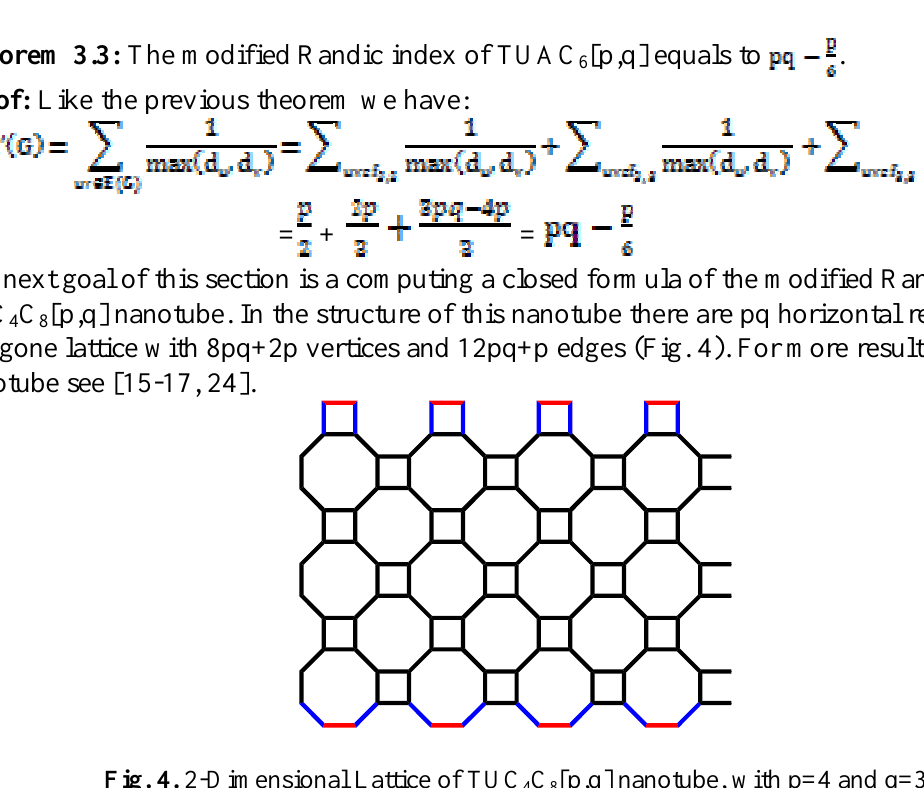
Fig. 4. 2-Dimensional Lattice of TUC